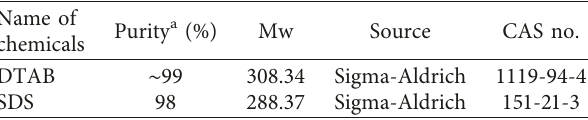
Table 2: Relative viscosity ( η ) of SDS-rich and DTAB-rich sur- r factants in the aqueous medium at the three different temperatures